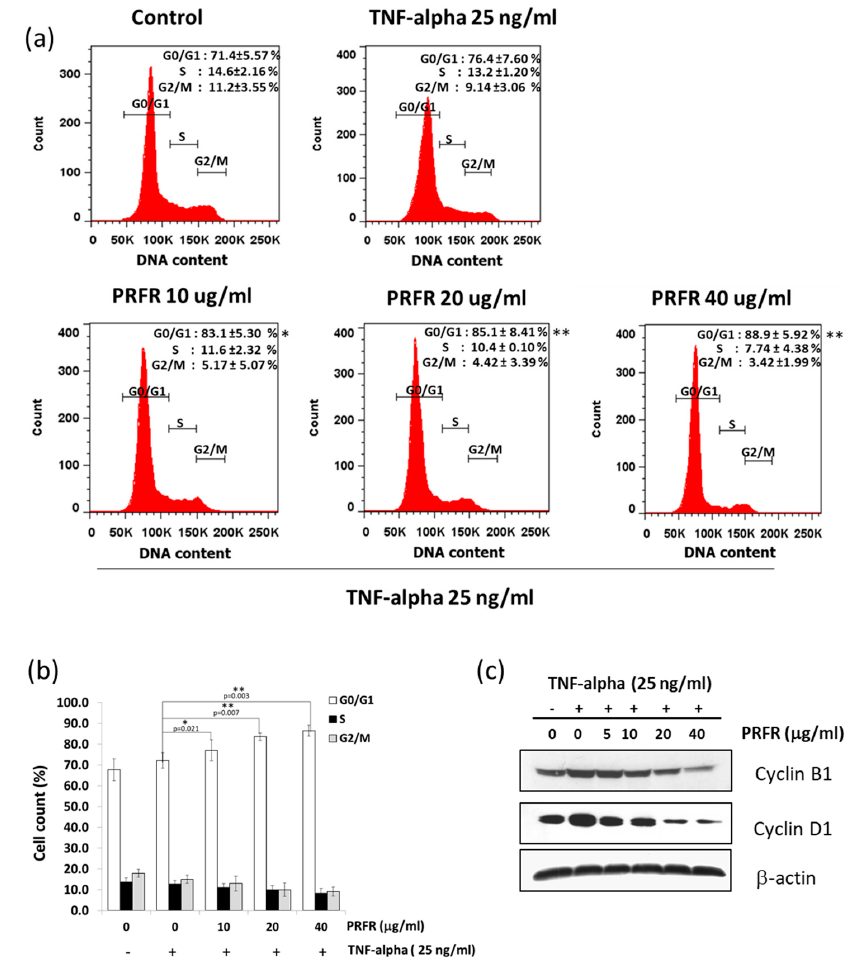
Figure 3. Effect of PRFR on TNF- α -induced cell proliferation. A549 cells were preincubated with Figure 3. E ff ect of PRFR on TNF- α -induced cell proliferation. A549 cells were preincubated